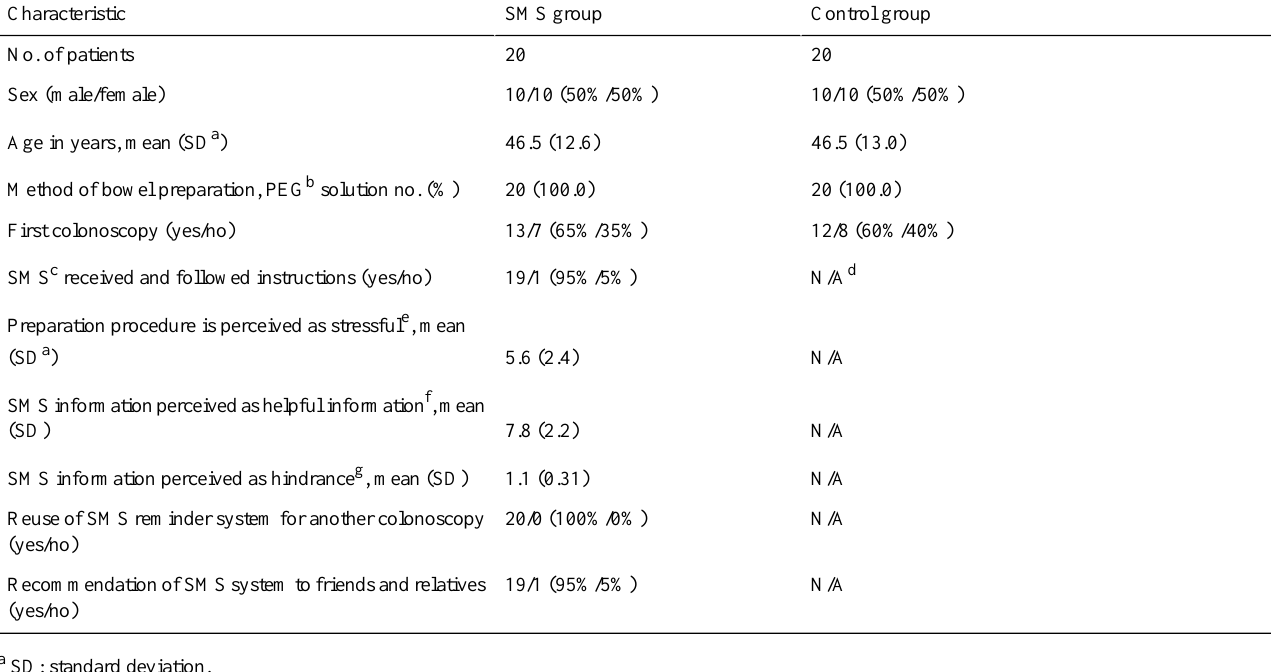
Table 2. Patient characteristics.